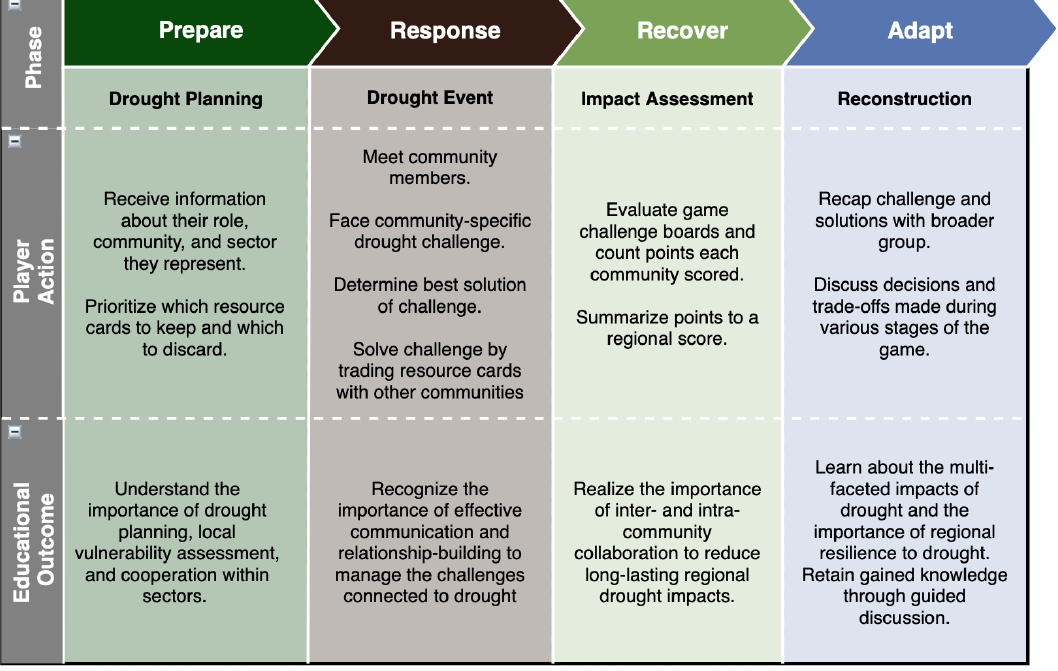
Figure 1. Flowchart of the game phases with corresponding player actions and educational outcomes.